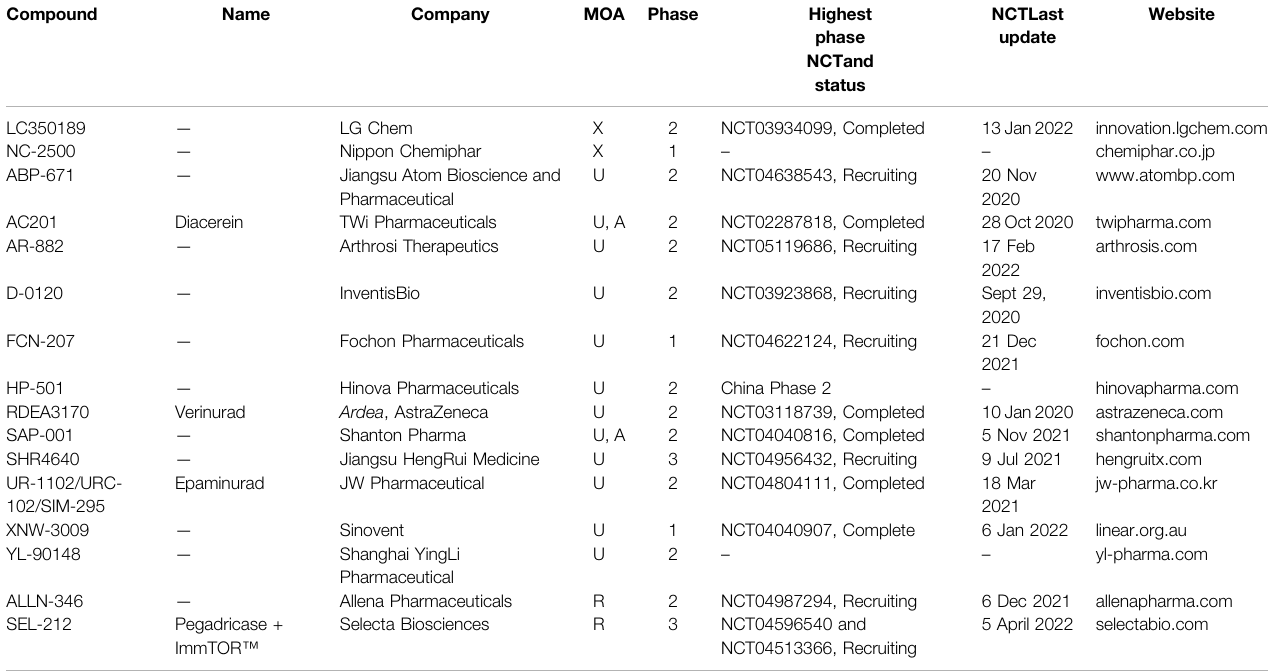
TABLE 2 | Developmental pipeline for urate-lowering therapeutic agents in the clinical phase of development.